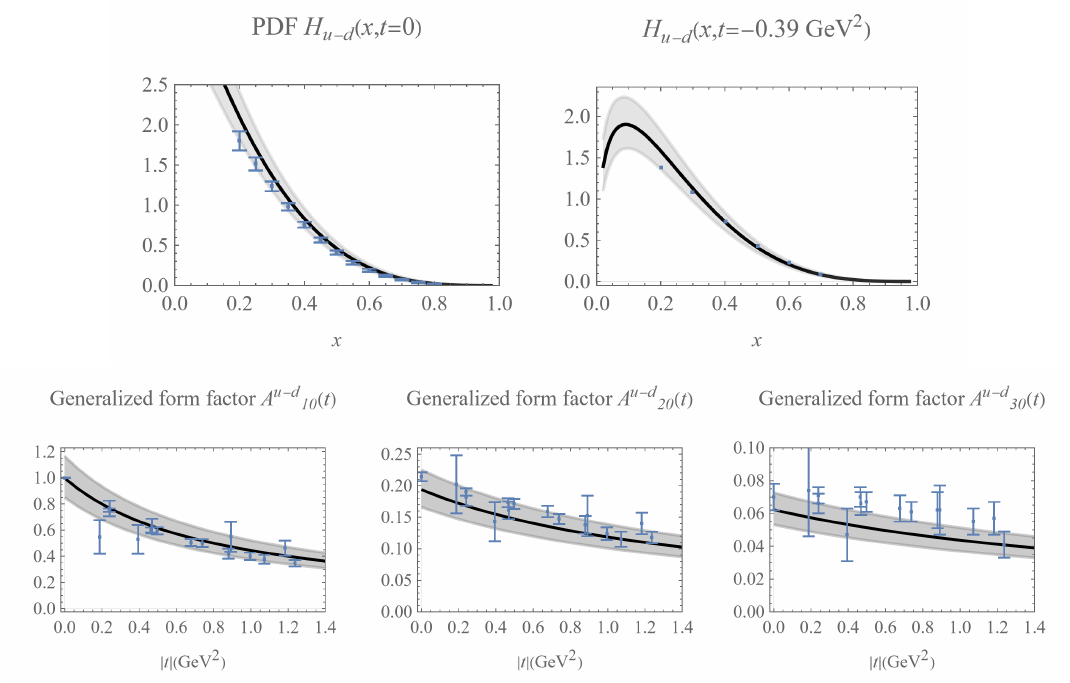
Figure 6 . A simultaneous fit to the forward PDF H u − d ( x ) (corresponding to the PDF q u − d ( x ) ) [43, 44], lattice calculated PDF H u − d ( x, t = − 0 . 39 GeV 2 ) [40] and generalized form factors A u − d A u − d ( t ) and A u − d ( t ) [32]. The solid lines are the central value of H u − d ( x, t ) , the gray bands 20 30